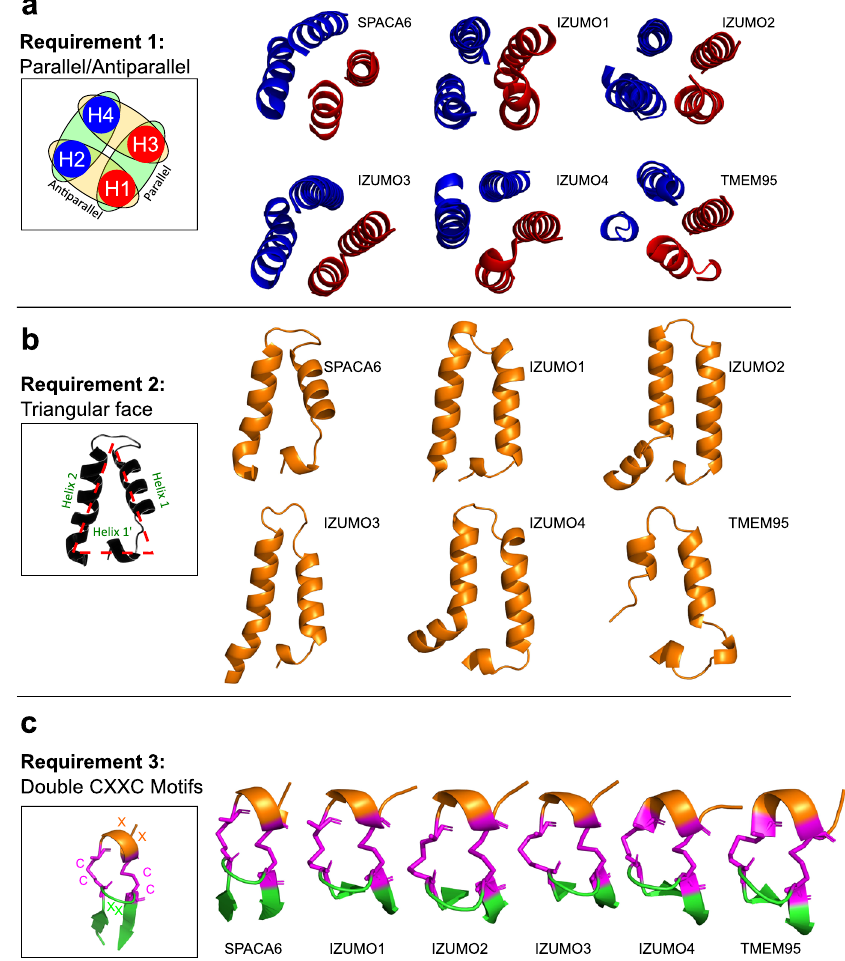
Fig. 5 Hallmark features of the IST gamete fusion-associated protein superfamily. Members of the IST superfamily are de fi ned by three hallmark features of the 4HB domain: a four helices that alternate between parallel and antiparallel orientations, b a triangular face of the helical bundle, and c a double CXXC motif that forms two disul fi des (magenta) between a small N-terminal helix (orange) and a β -hairpin (green) in the hinge